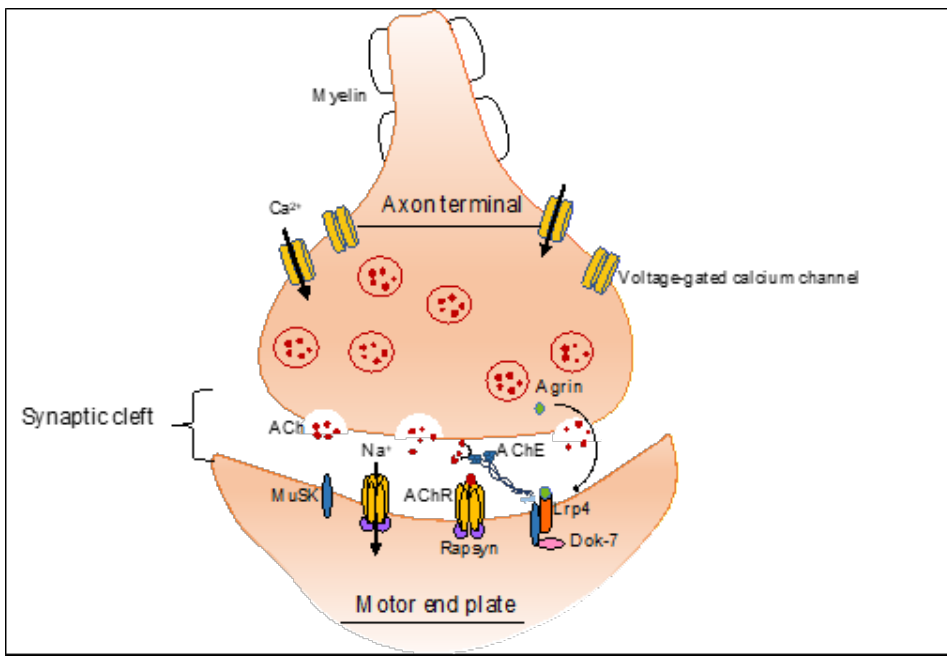
Figure 1. Schematic representation of the neuromuscular junction. Nerve impulse transmission is ensured by the voltage-gated calcium channel, AChR and AChE. The increase in Ca 2+ facilitates the fusion of synaptic vesicles with the presynaptic membrane and the consequent release of ACh in the synaptic cleft. The ACh-AChR complex induces opening of the ligand-gated ion channels and muscle membrane depolarization, thus generating muscle contraction. Signal transmission is interrupted by the breakdown of ACh, catalyzed by the AChE, which is anchored to the postsynaptic membrane through MuSK. Furthermore, MuSK forms a complex with Lrp4 and Dok-7, which binds the neural agrin and induces a phosphorylation cascade. Phosphorylated MuSK triggers phosphorylation of other intracellular proteins, such as rapsyn, thus promoting the formation of the AChR cluster, which is necessary for the maintenance of the postsynaptic